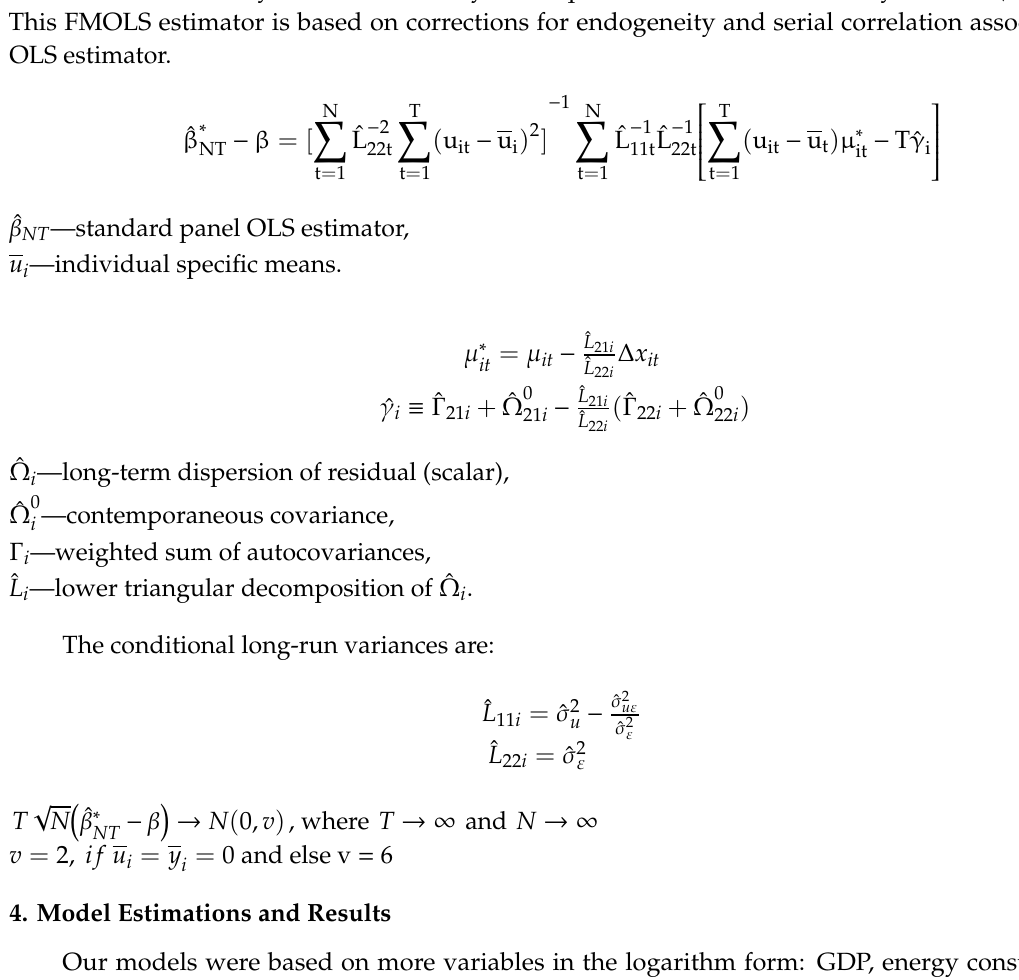
ˆ β NT —standard panel OLS estimator, u i —individual specific means.